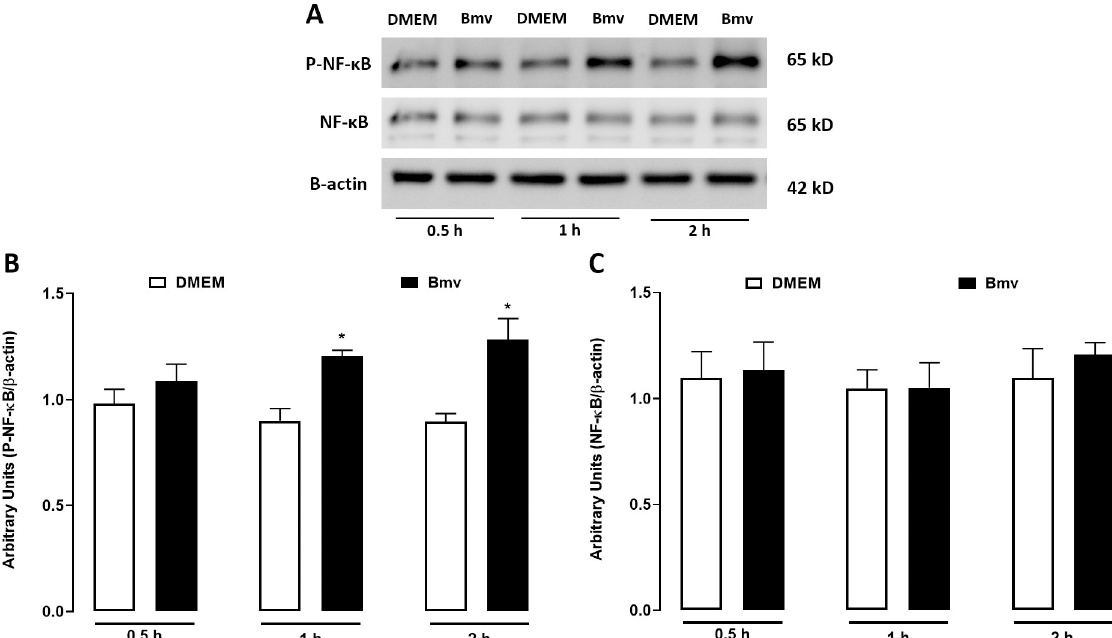
Fig 5. Bmv activates NF- κ B in preadipocytes. 3T3-L1 preadipocytes were stimulated with Bmv (1 μ g/mL) or DMEM (control) for 0.5, 1, or 2 h. P-NF- κ B and NF- κ B protein expression was evaluated by western blotting. (A) Representative immunoreactive bands for P-NF- κ B, NF- κ B and β -actin (loading control). Densitometric analysis of immunoreactive bands of (B) P-NF- κ B and (C) native NF- κ B. Results are expressed as mean + SEM (n = 3). � p < 0.05 vs. control (ANOVA and Bonferroni post